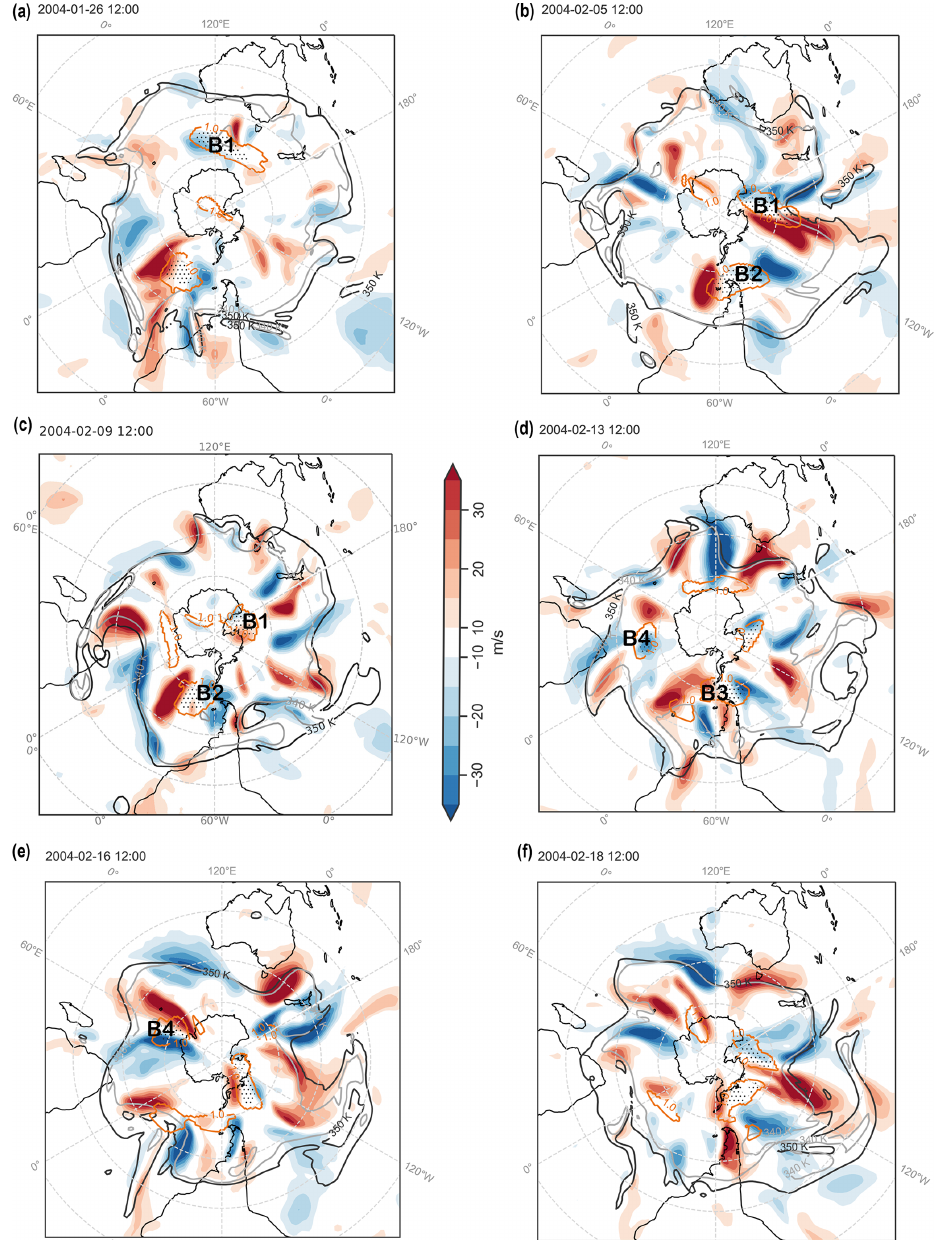
Figure 5. (a–f) Meridional velocity at 250hPa (colour shading), 2PVU contours at isentropes 340K (grey line) and 350K (black line) at various time steps. Stippling and orange contours show blocks identified using a 1.3 and 1.0PVU threshold,